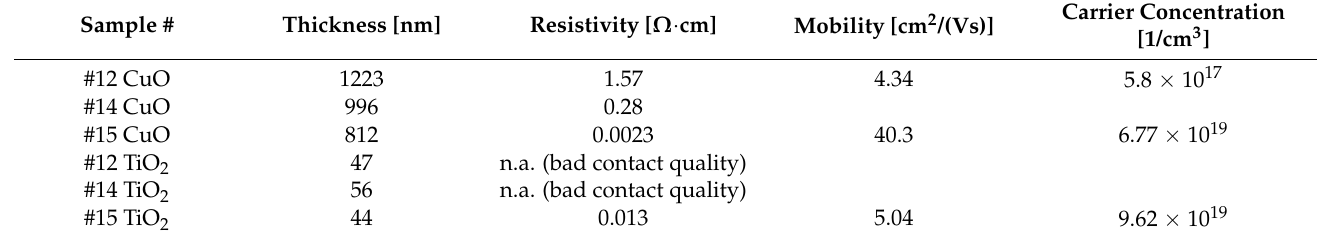
Table 6. Resistivity of measured layers, mobility, and concentration for selected layers.